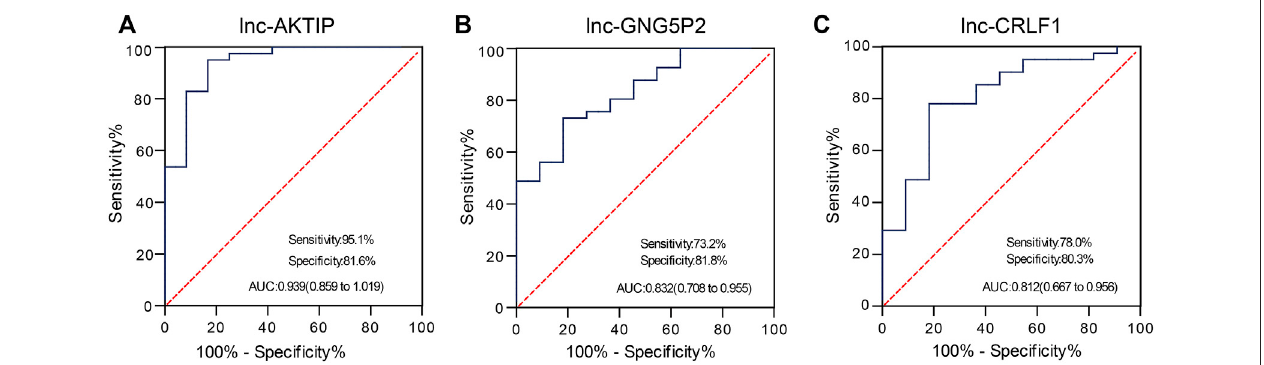
FIGURE6| ROCcurve analysiswasusedtoevaluate thediagnostic contributionsoflnc-AKTIP,lnc-GNG5P2, and lnc-CRLF1indiscriminatingSNIP patients.The ROC curve showing the Area under Curve (AUC), sensitivity and speci fi city of lnc-AKTIP (A) , lnc-GNG5P2 (B) or lnc-CRLF1 (C) as a biomarker of SNIP.